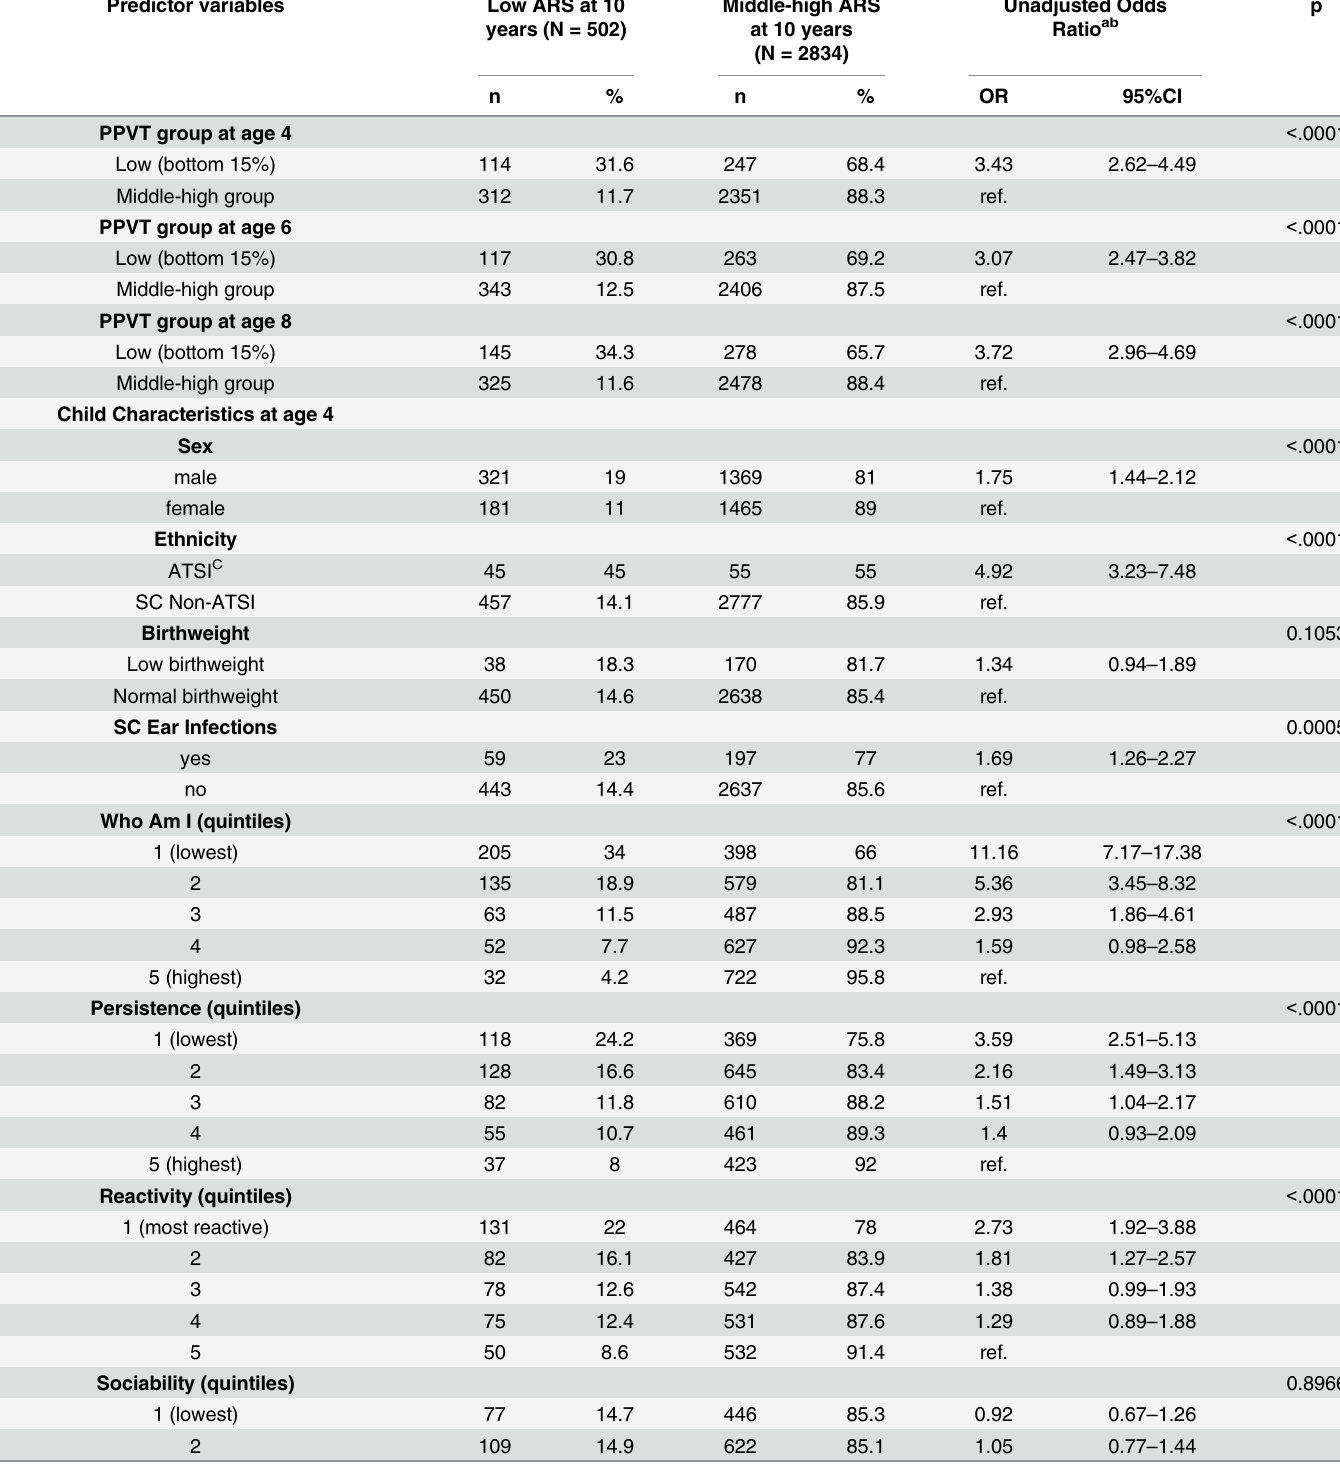
Table 4. Initial candidate predictors: Child, maternal and family characteristics of children in the low literacy and middle-high literacy groups at 10 years. Predictor